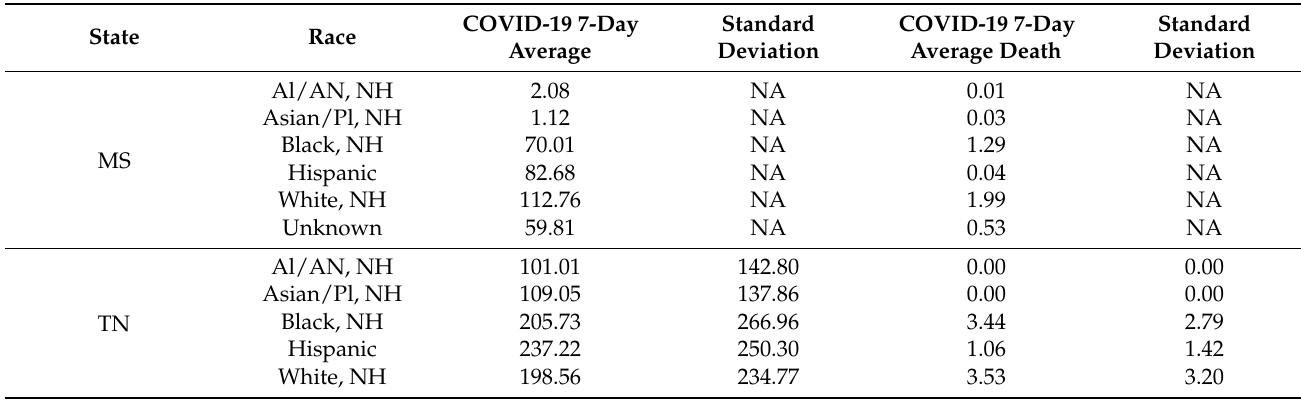
Table 4. Rates of socioeconomic status variables and the percent of racial populations.